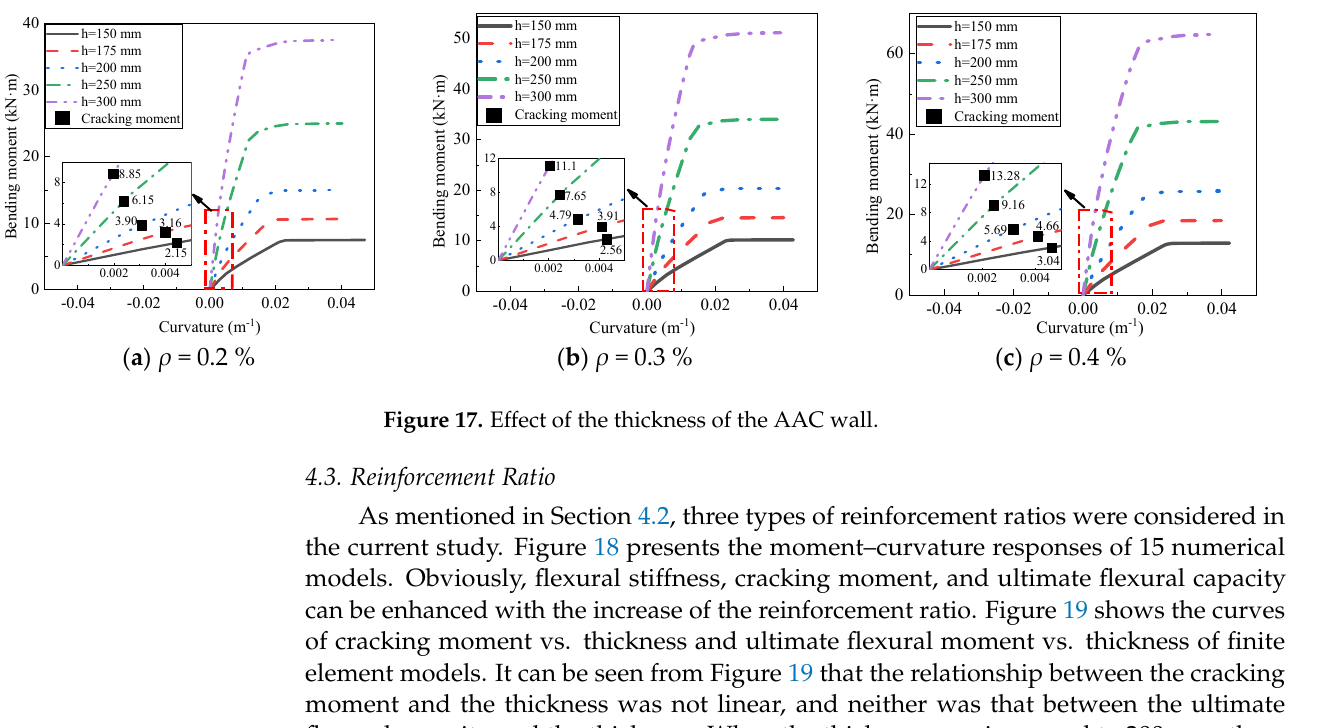
Figure 16. Flexural behavior of the numerical model S-A77-1 [17].